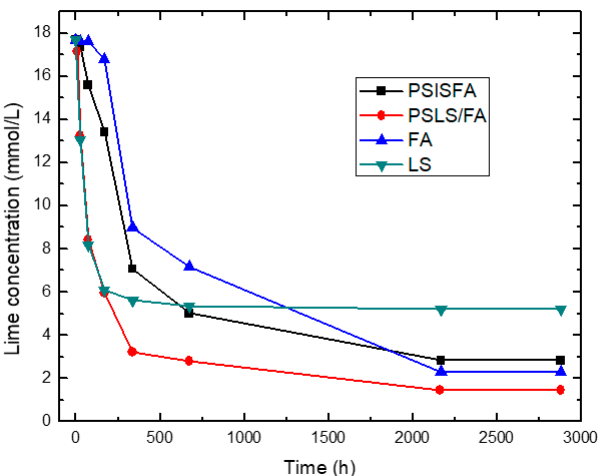
Figure 3. Variation of electrical conductivity with reaction time for the binary system PSIS + FA, PSLS + FA.